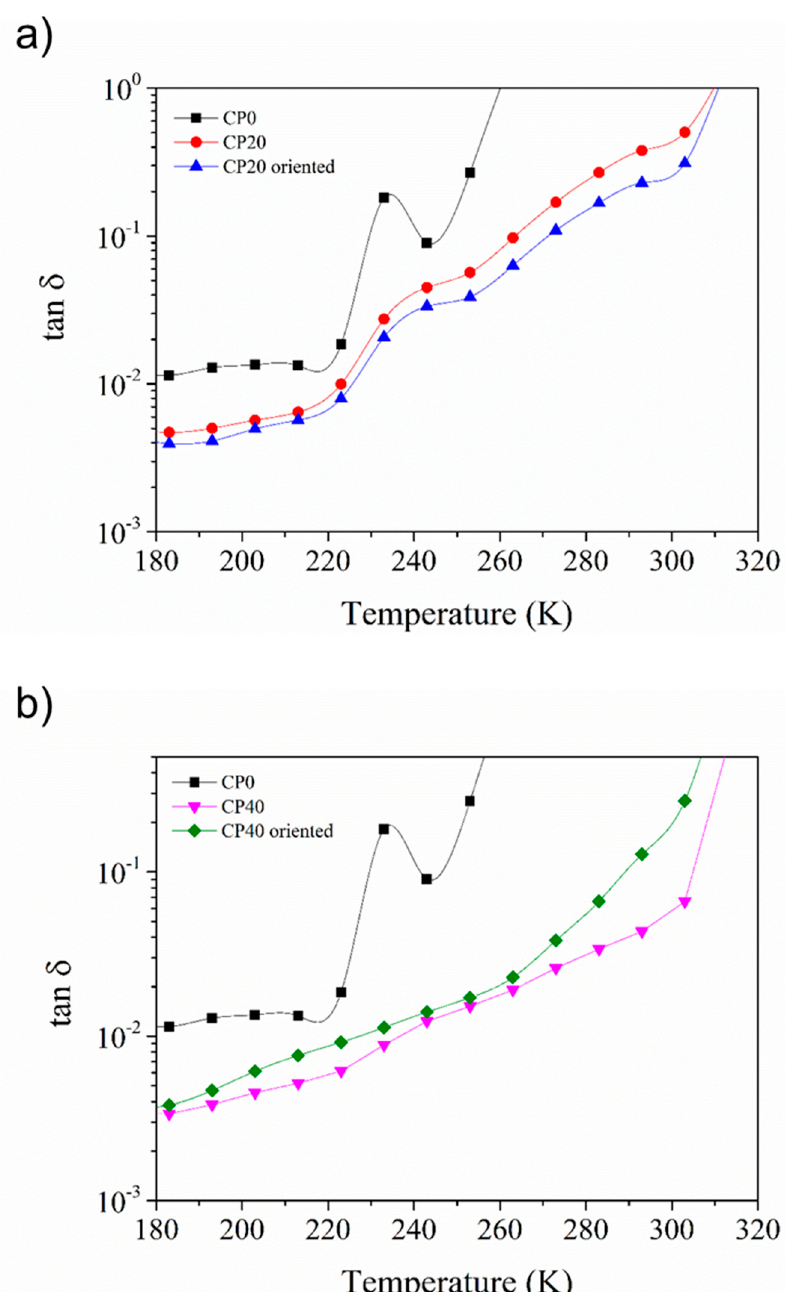
Figure 8. Tan δ of the: ( a ) unmodified (COP0) and modified oriented and unoriented copolymer CP20; and ( b ) modified oriented and unoriented copolymer CP40, respectively, for a frequency of 10 Hz.